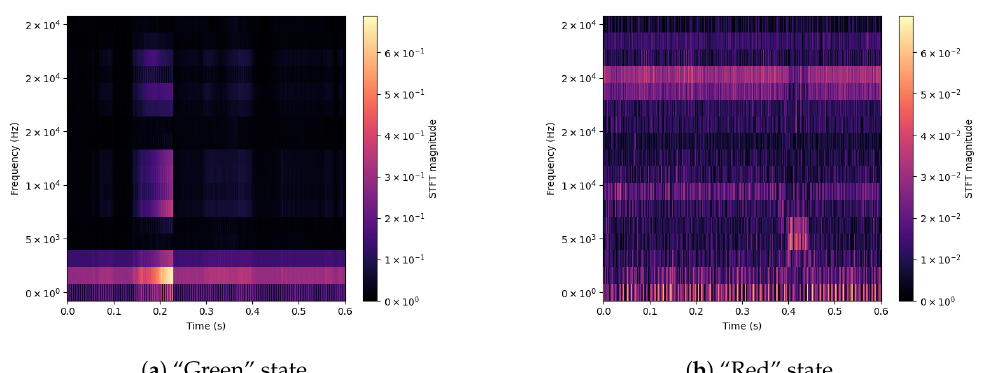
Figure 6. Signal spectrograms of DataCurrent for Green/Red